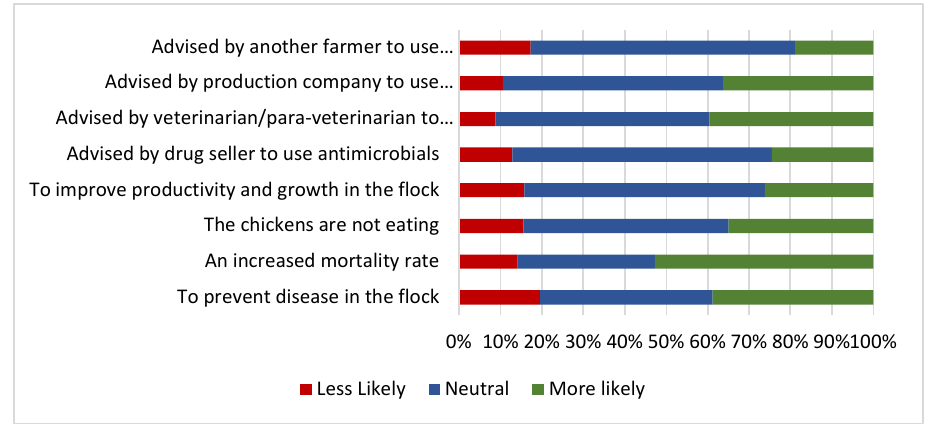
Figure 2. Drivers for antimicrobial use by broiler farmers in the small commercial broiler sector in Indonesia ( n = 509).